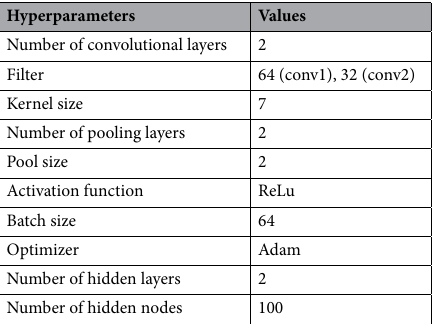
Table 5. Hyperparameter tuning of CNN model with padding data for detection.